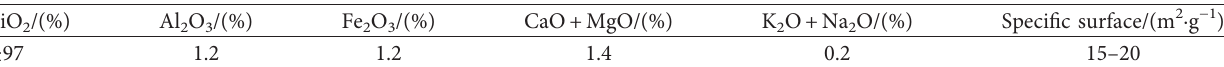
Table 2: Properties of silica fume.